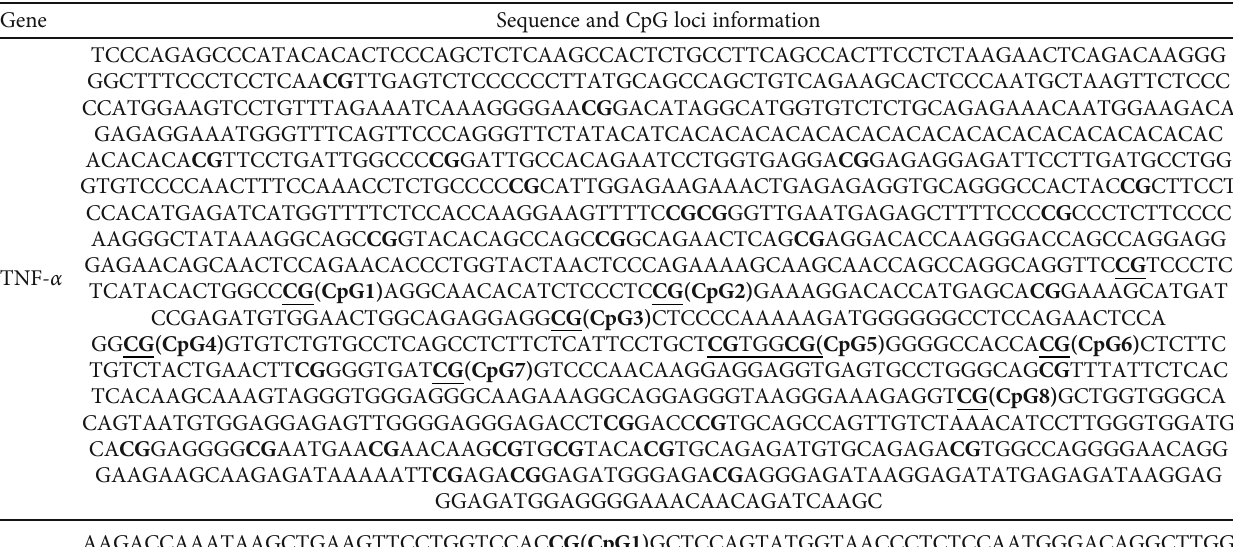
Table 1: The gene sequence information of IL-10 and TNF- α . Sequence and CpG loci